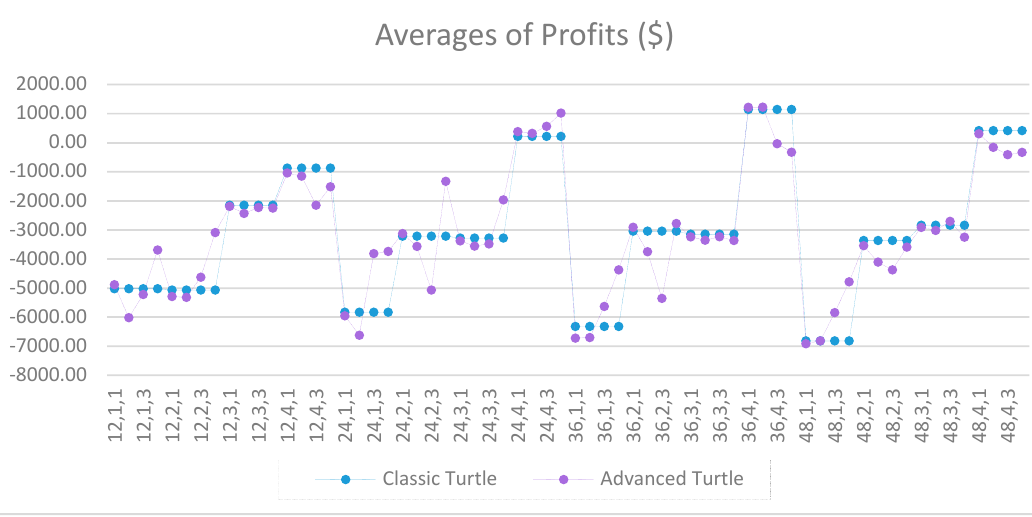
Figure 14. Averages of drawdowns as percentage of equity between the classic and the advanced Turtle systems for every combination of N, X, Y for the slow parameters (80, 160). 4. Exceptions We tried using extraordinary values of the stop loss multiplier X: {5, 6, 7} and examined the classic and the advanced Turtle using the slow parameters {80, 160} as they provided better results. Figure 15 shows the average of profits of the assets and Figure 16 the average of drawdowns of the assets for every combination of N, X and Y. Using extraordinary values for the stop loss multiplier X, the classic Turtle outperforms the advanced Turtle. Additionally, comparing Figures 13 and 15, profits are higher with higher values of X, a fact which makes the stop loss zone wider, while chances of a stop loss being triggered are slimmer. In other words, the less our Turtle expert advisors use the ATR stop loss windows, the better the results are bound to be, and the exclusion zone becomes redundant.